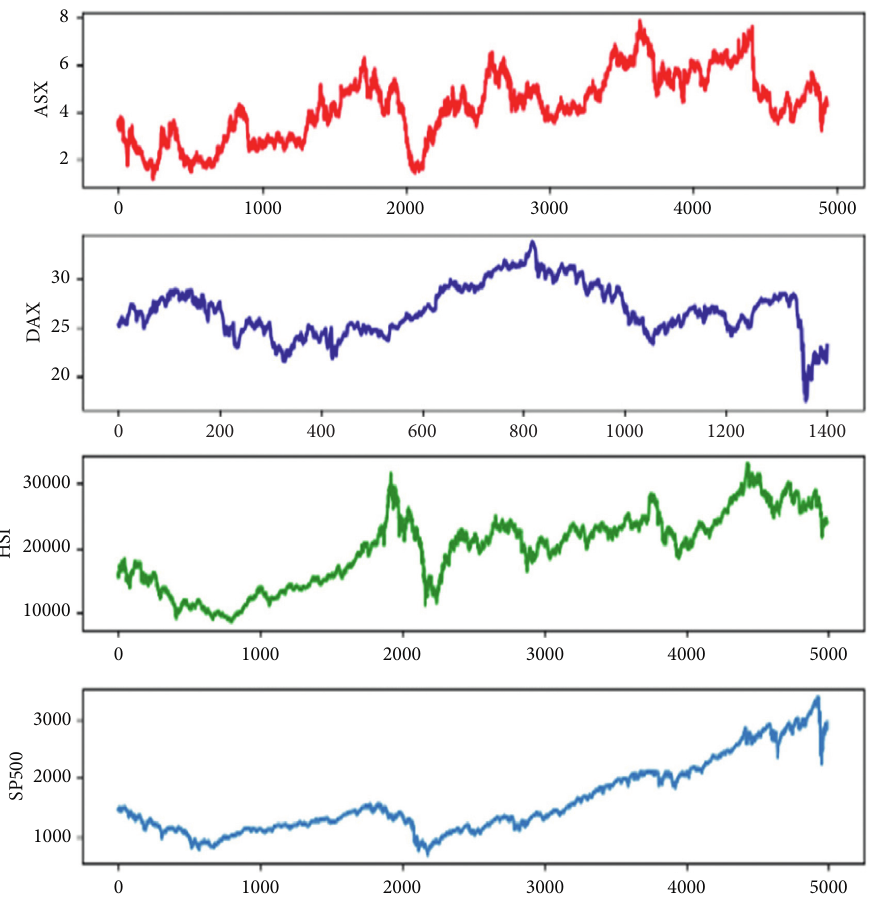
Figure 8: The trend of the four major stock indexes.